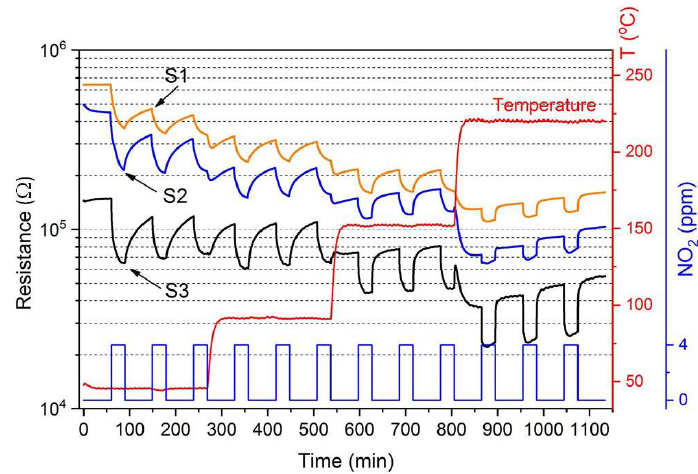
Figure 7. Variation of resistance of a multilayer sensor structures 4LbL with measurement temperature during interaction with NO 2 pulses of a concentration 4 ppm in air. Thickness of the CuO layers increased from S1 to S3.